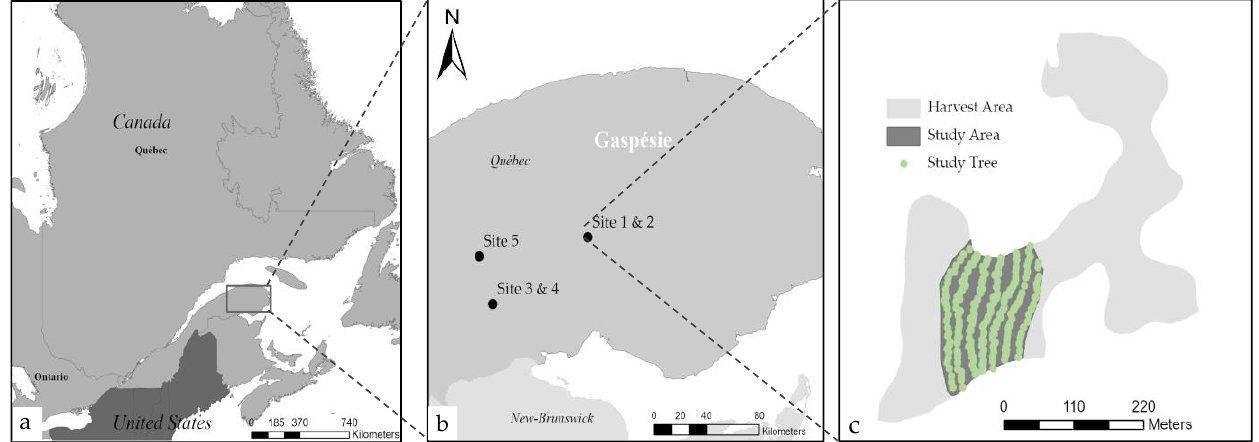
Figure 1. ( a ) General location of the targeted Gaspésie region of Québec, Canada; ( b ) Location of the five harvest areas; ( c ) Close-up of a harvest area and study area.